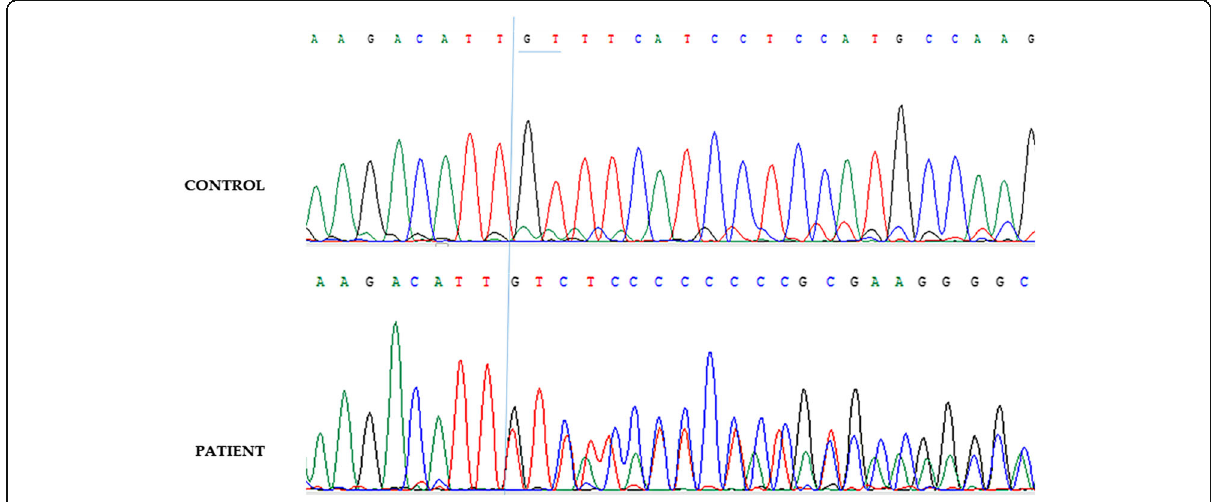
Fig. 1 Sanger sequencing result of the patient with novel mutation (c.1384 – 1385 del